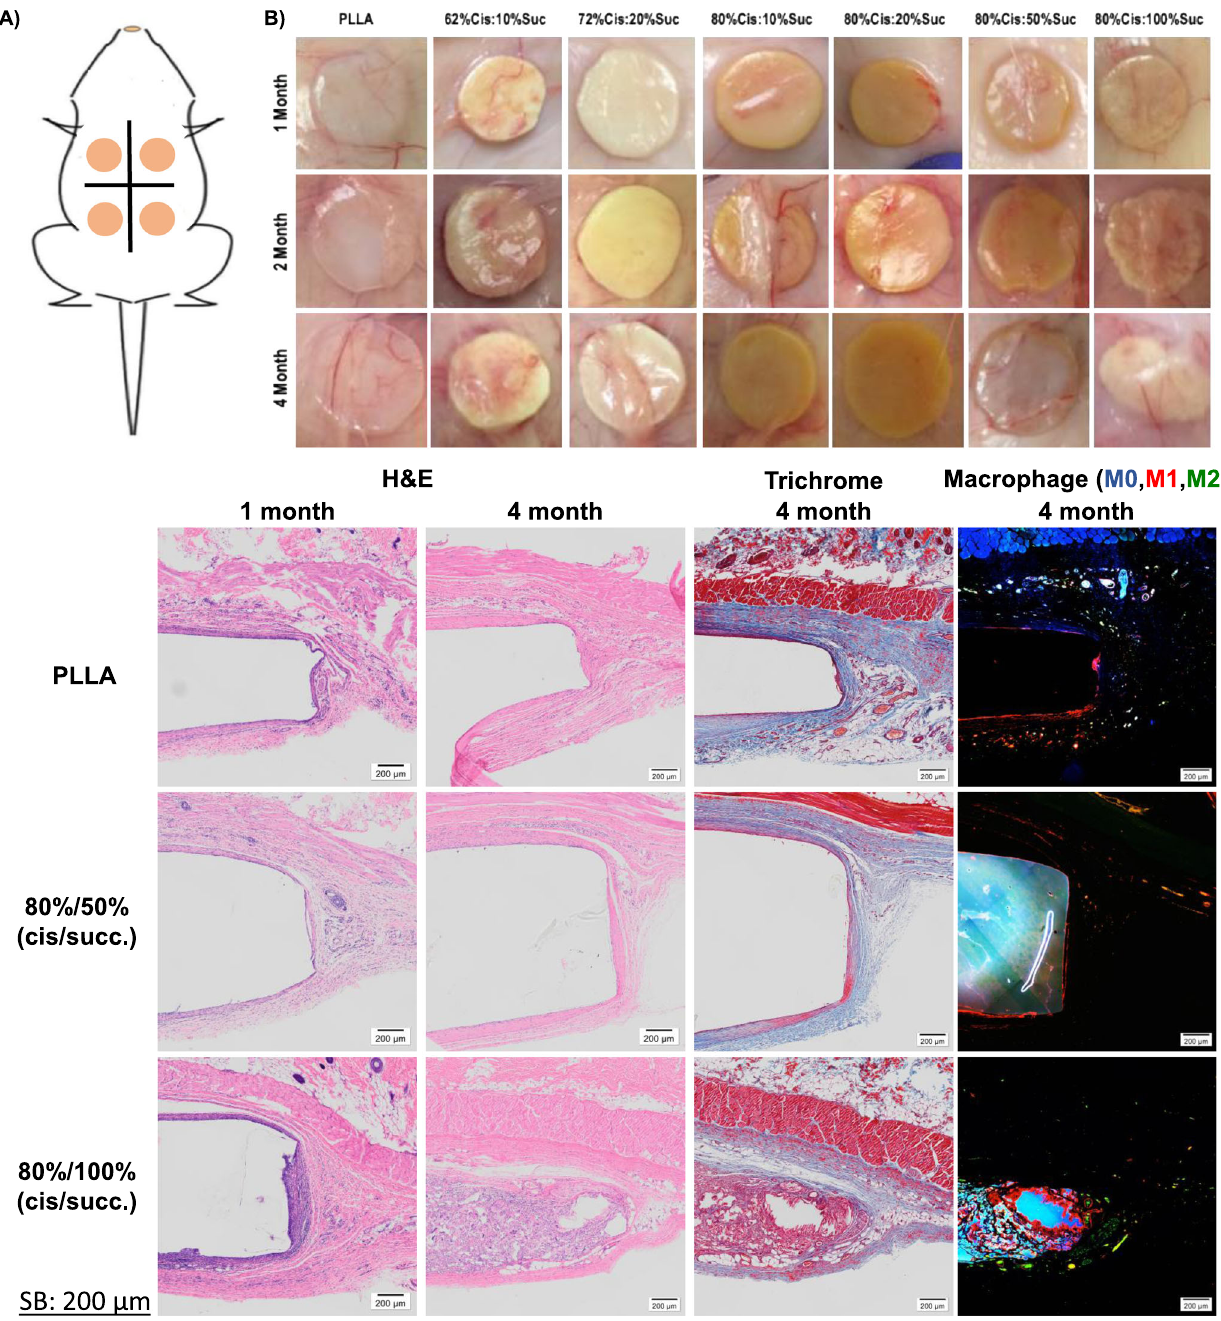
Fig. 5 Subcutaneous in vivo degradation of Poly(L-lactic acid) (PLLA), 80% cis /50% succinate and 80% cis /100% succinate over a 4-month timeframe. Surgical procedures with subcutaneous implantation involved a small incision, polymer disc insertion, and incision closure with Michel-clips. Four samples were implanted per animal ( A ). ( B ) Following extraction, the implants can be visualized in the host tissue using Hematoxylin and Eosin (H&E) and Masson ’ s Trichrome staining. As seen, there are almost no macroscopic indications of an in fl ammatory response. Whole-mount cross-section images showing thick fi brous encapsulation surrounding PLLA after 4 months of incubation in vivo are observed. Similar behavior to PLLA is observed for 80% cis/ 50% succinate at 1- and 4-months implantation. Alternatively, the early stages of cellular in fi ltration are noticed in 80% cis /100% succinate after only 1 month (I). After 2- (Supplementary Fig. 23) and 4- months, noticeable shrinking/resorption of the polymer was seen with continued cellular in fi ltration. Degradation after 4 months is nearly complete with cells, deposited collagen, and tissue fully encompassing the polymer area. Blood vessel sprouts and multinucleated giant cells are noticeable throughout the polymer space that has been resorbed. Trichome images show collagen deposition and immunohistochemistry staining macrophages for pro-in fl ammatory ( M1 ), non-activated ( M0 ), and anti-in fl ammatory ( M2 ) macrophages show degradation induced in fl ammation and remodeling. Inset scale bar = 200 μ m. Shown micrographs are representative of histology specimens ( n = 4) from each of six independent implants ( n = 6) for each